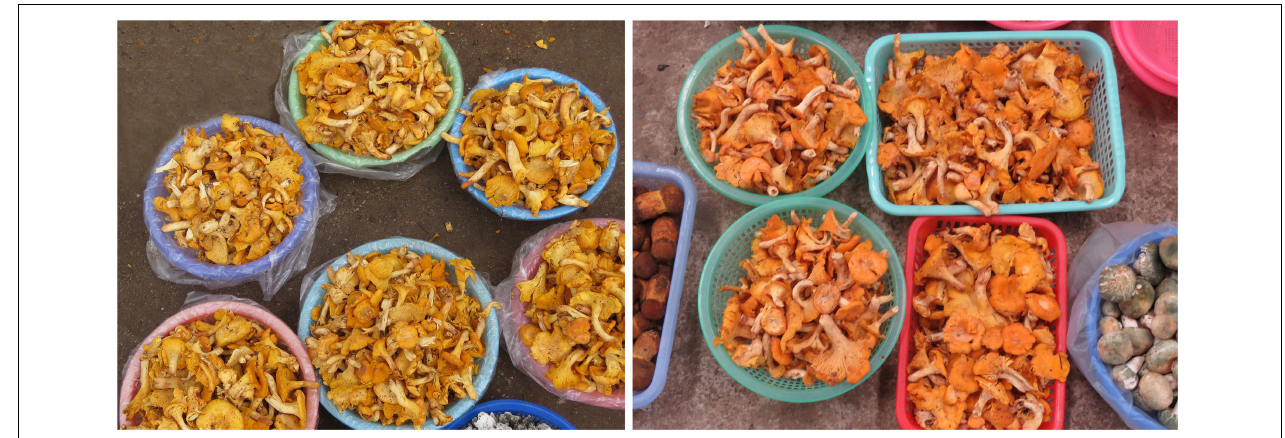
FIGURE 1 | Collections of chanterelle sold as edibles in the market of Yunnan Province, southwestern China. Photographs were taken by N. K.